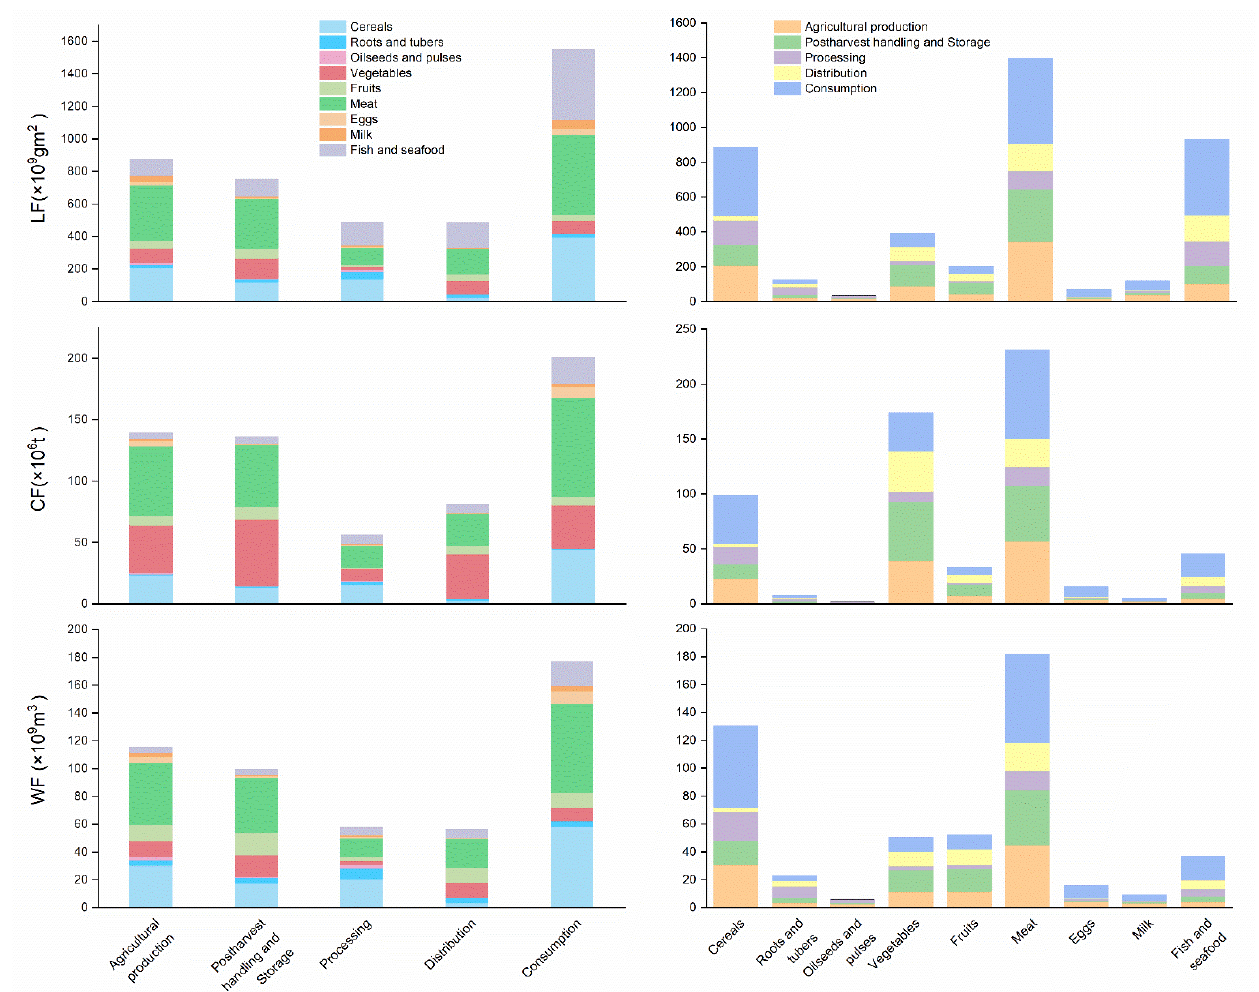
Figure 6. The state of environmental footprints embedded in FLW.